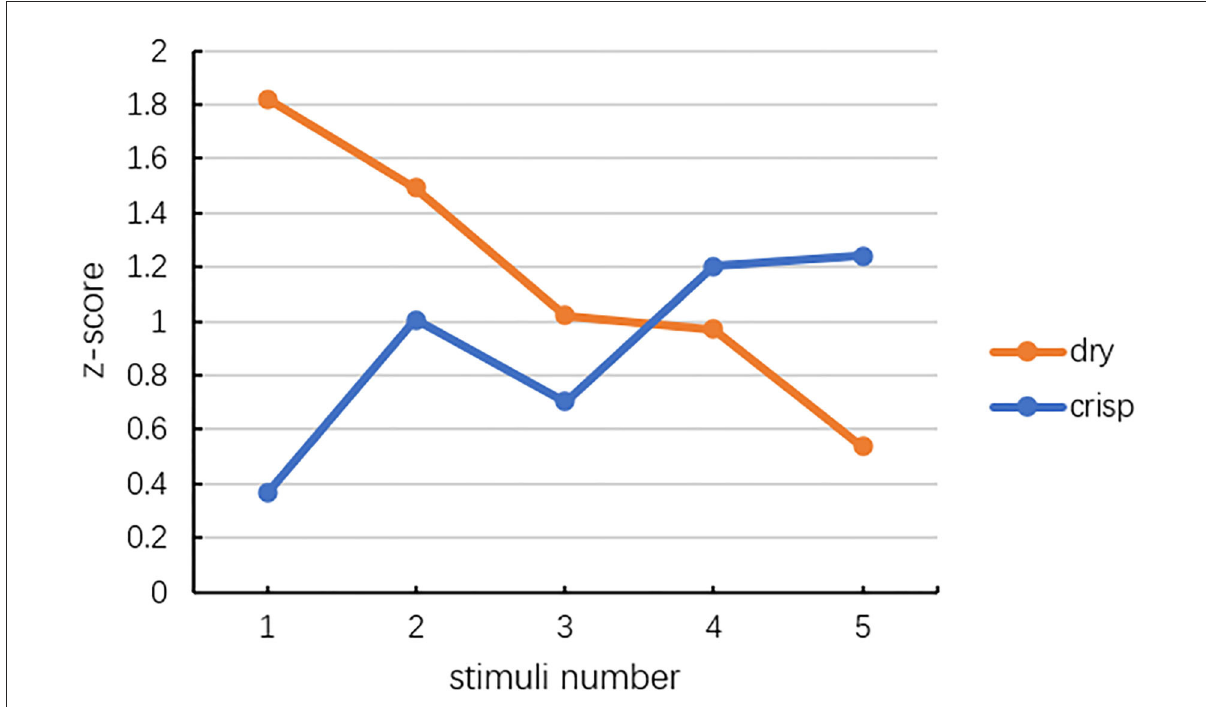
FIGURE5 The z- scores of five